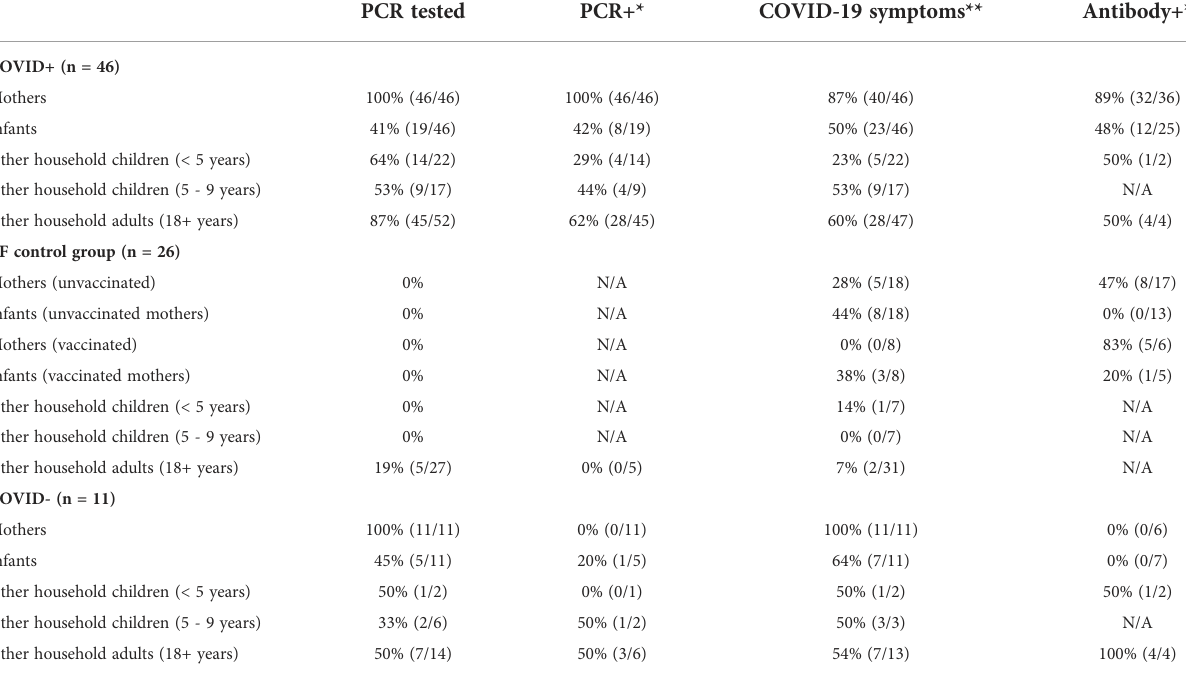
TABLE 5 COVID-19 PCR testing, symptom, and antibody testing results for mothers, infants, and other household members by enrollment group. PCR tested